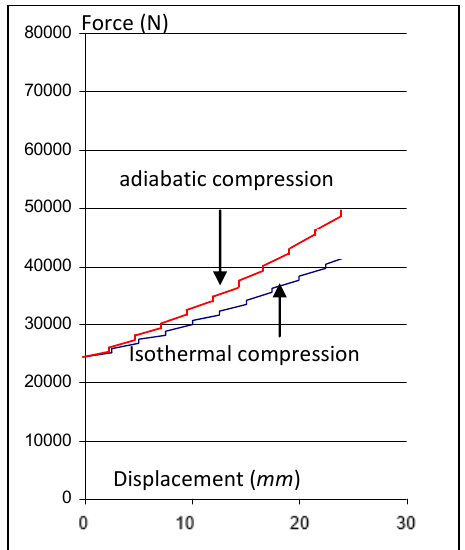
Figure 5. Internal reaction vs axial displacement (in compression) of the pneumatic spring with isothermal and adiabatic ( γ = 1.3) processes. Initial internal pressure p 0 = 2 bar (displacements indicated are half of each prescribed spring stroke for symmetry).